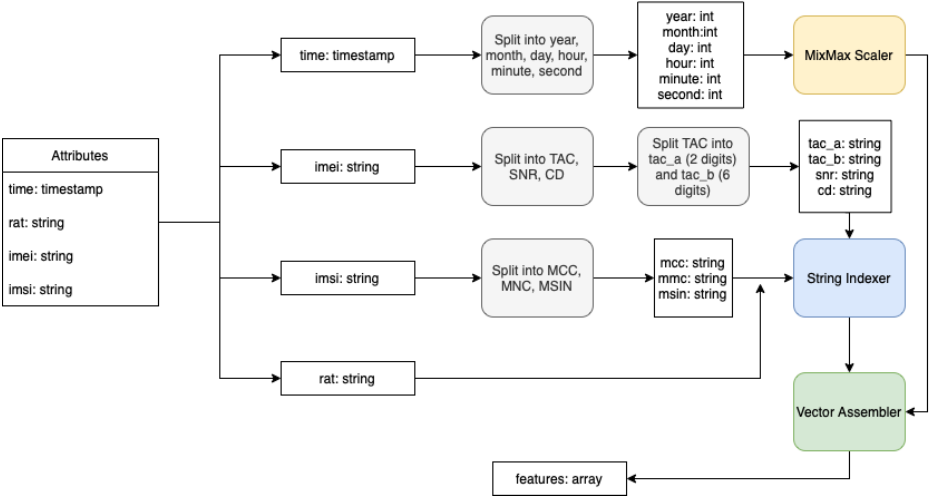
Figure 5. Preprocessing flow of Mobile Network device data.